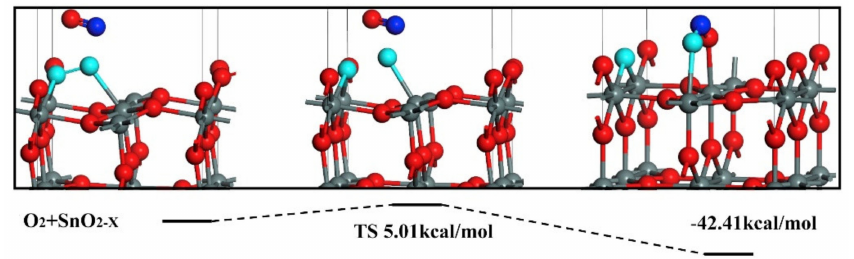
Figure 5. Coadsorption of NO and O 2 onto a reduced (110) surface of SnO 2 . Reproduced with permission from Reference